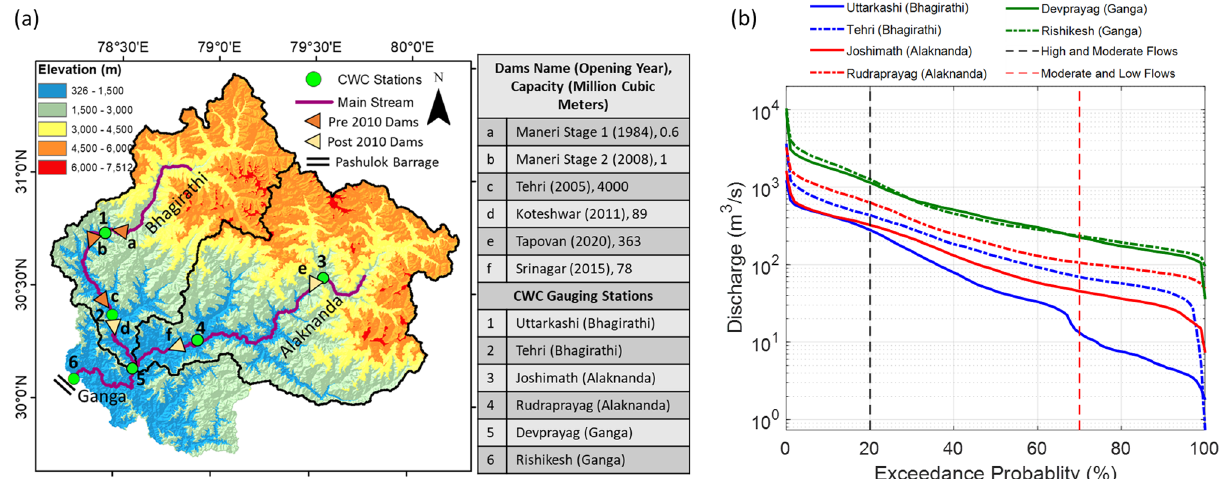
Figure 1. (a) Digital Elevation Model (DEM) of the UGB. The major stream network is also shown in the map using magenta lines. The CWC stations and dams are illustrated using filled green circles, orange and yellow triangles, respectively. Parallel black lines show the Pashulok barrage, located below the Rishikesh. Further, the name of dams and corresponding opening year is also shown in the side table. The QGIS Version 3.2